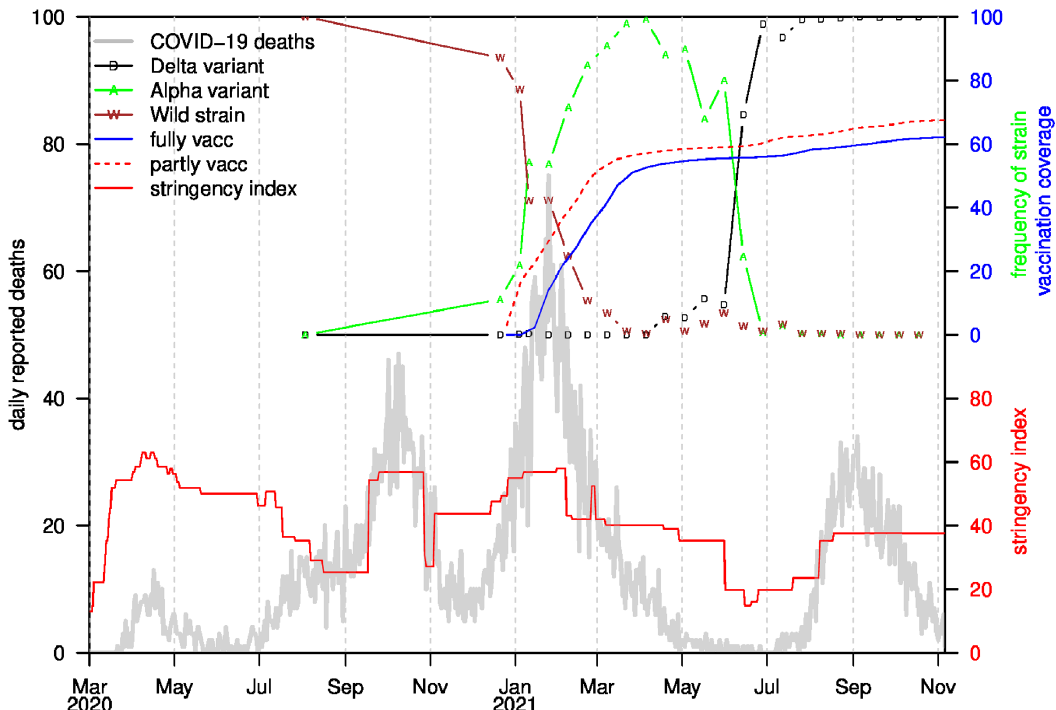
Fig 1. Daily reported COVID-19 deaths (grey) over pandemic period. Colored symbols show frequency of individual strains (as a percentage) of all strains sequenced (mostly biweekly) in Israel. Also plotted is the vaccination coverage (i.e. proportion of the population being vaccinated) with solid blue representing fully vaccinated and red dashes for partially vaccinated (one dose), bold grey curve for the daily reported COVID-19 deaths. The Alpha variant replaced the wild-type strain in December 2020-Febrary 2021, while the Delta replaced the Alpha variant in June-July 2021. The final wave in the graph is almost completely due to the Delta variant. The solid red curve represents the stringency index (see SI4).